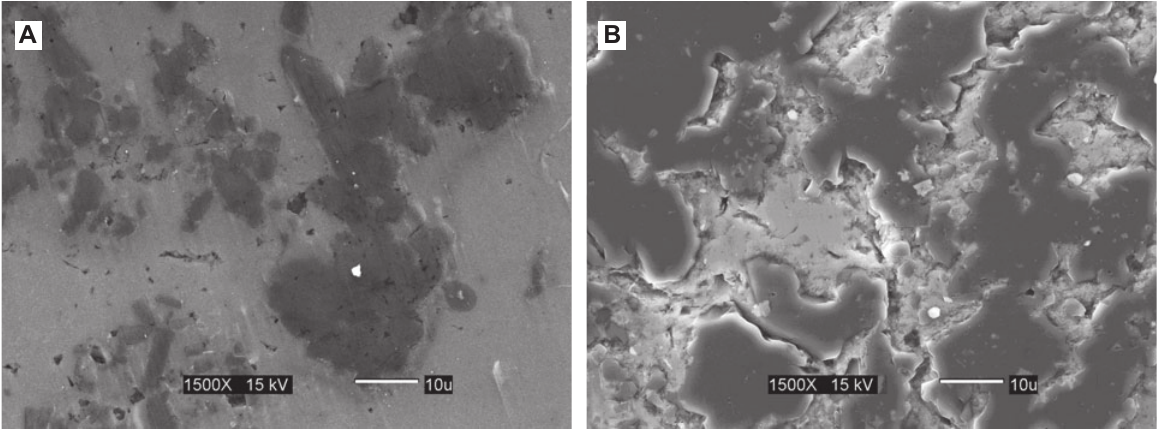
Figure 4 SEM secondary electron images of undamaged areas of Al-B-Si composites: (A) AlB